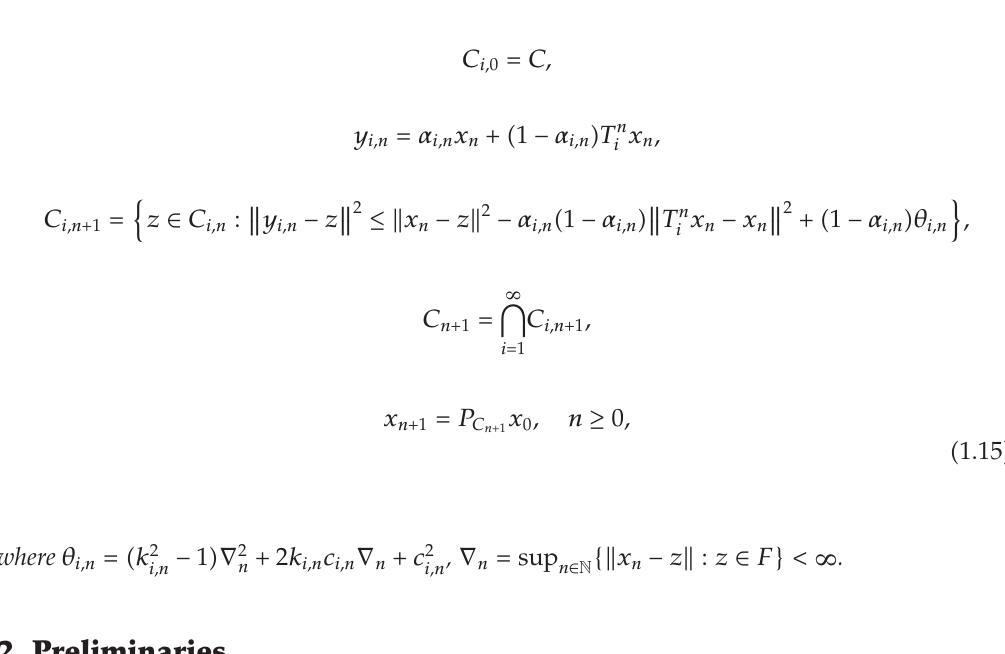
Algorithm 1.4. For an initial point x 0 ∈ C , compute the sequence { x n } by the iterative